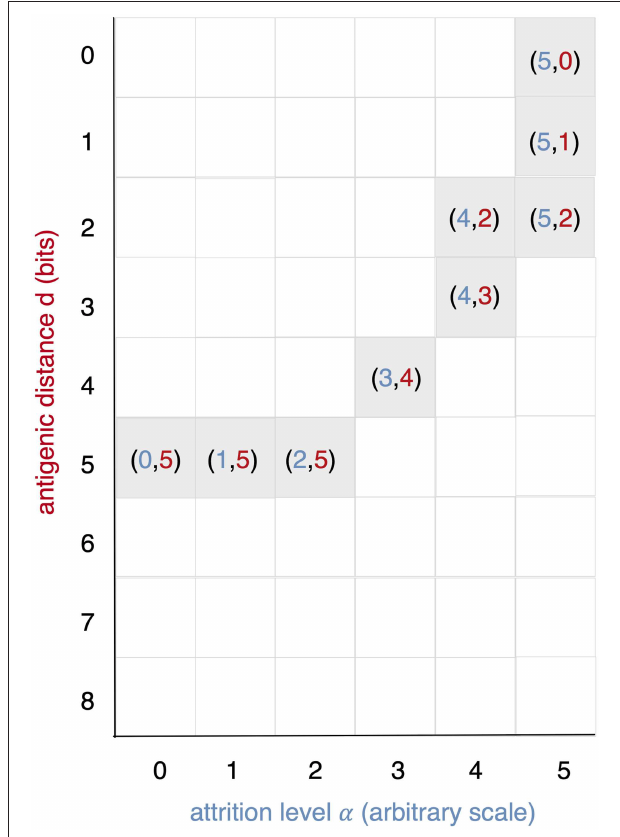
FIGURE 4 | This diagram is meant as a visual help to the analysis of Figure 3 and keeps on the same coordinates: virus distance ( d = 0...8) vs. attrition level ( α = 0 ... 5). In Figure 3 we see that memory is strong and dominant but can be trimmed down by turning two independent knobs: the first increases d and affects affinity, the second through attrition , thins the memory cell population, by inducing apoptosis. If both knobs are turned up in the same run a synergic effect is observed. The equal counts of memory and naive cells are due to the fact that in the clearing of the virus that in the clearing of the virus the total affinity required is contributed equally by the two